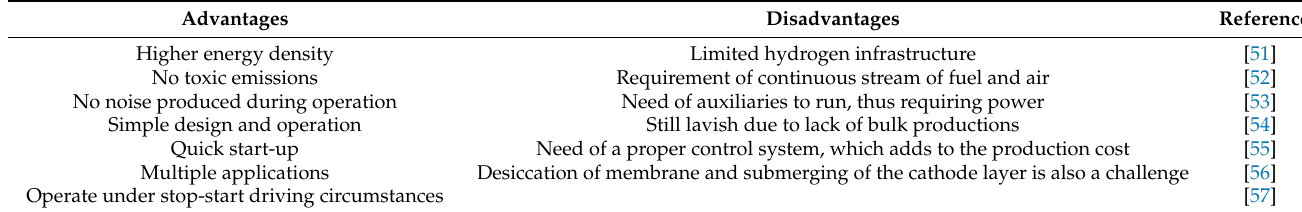
Table 2. Advantages and disadvantages of proton-exchange membrane fuel